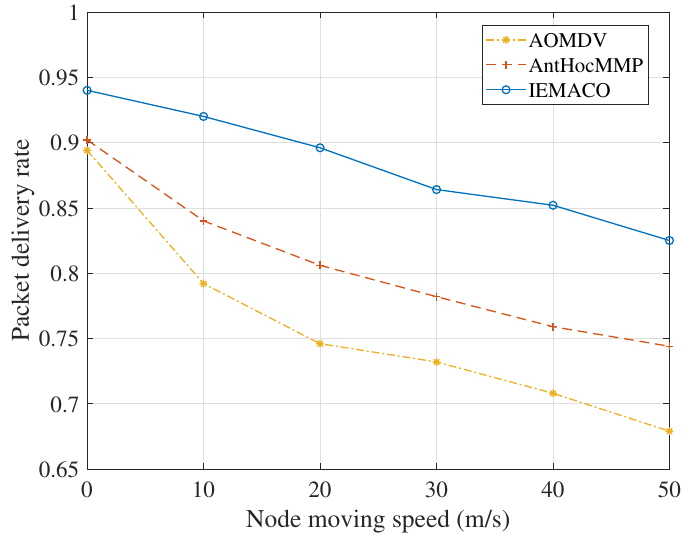
Figure 5. Packet delivery rate versus node moving